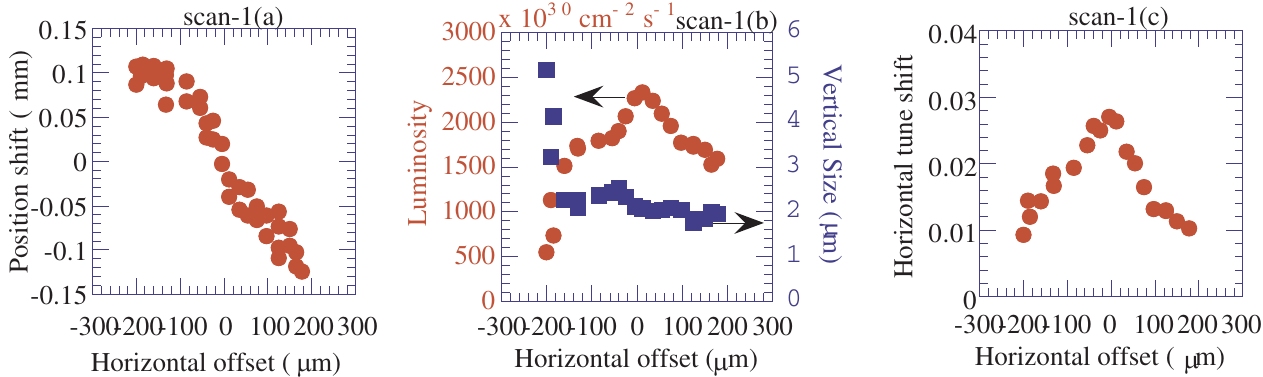
FIG. 6. (Color) Variations of the beam parameters as a function of the horizontal offset with the beam condition of scan-1 (relatively low current). Position shift at LER-2 (a), luminosity (red dots) and vertical beam size of the positron beam at the IP (blue squares) (b), and horizontal beam-beam tune shift (c).